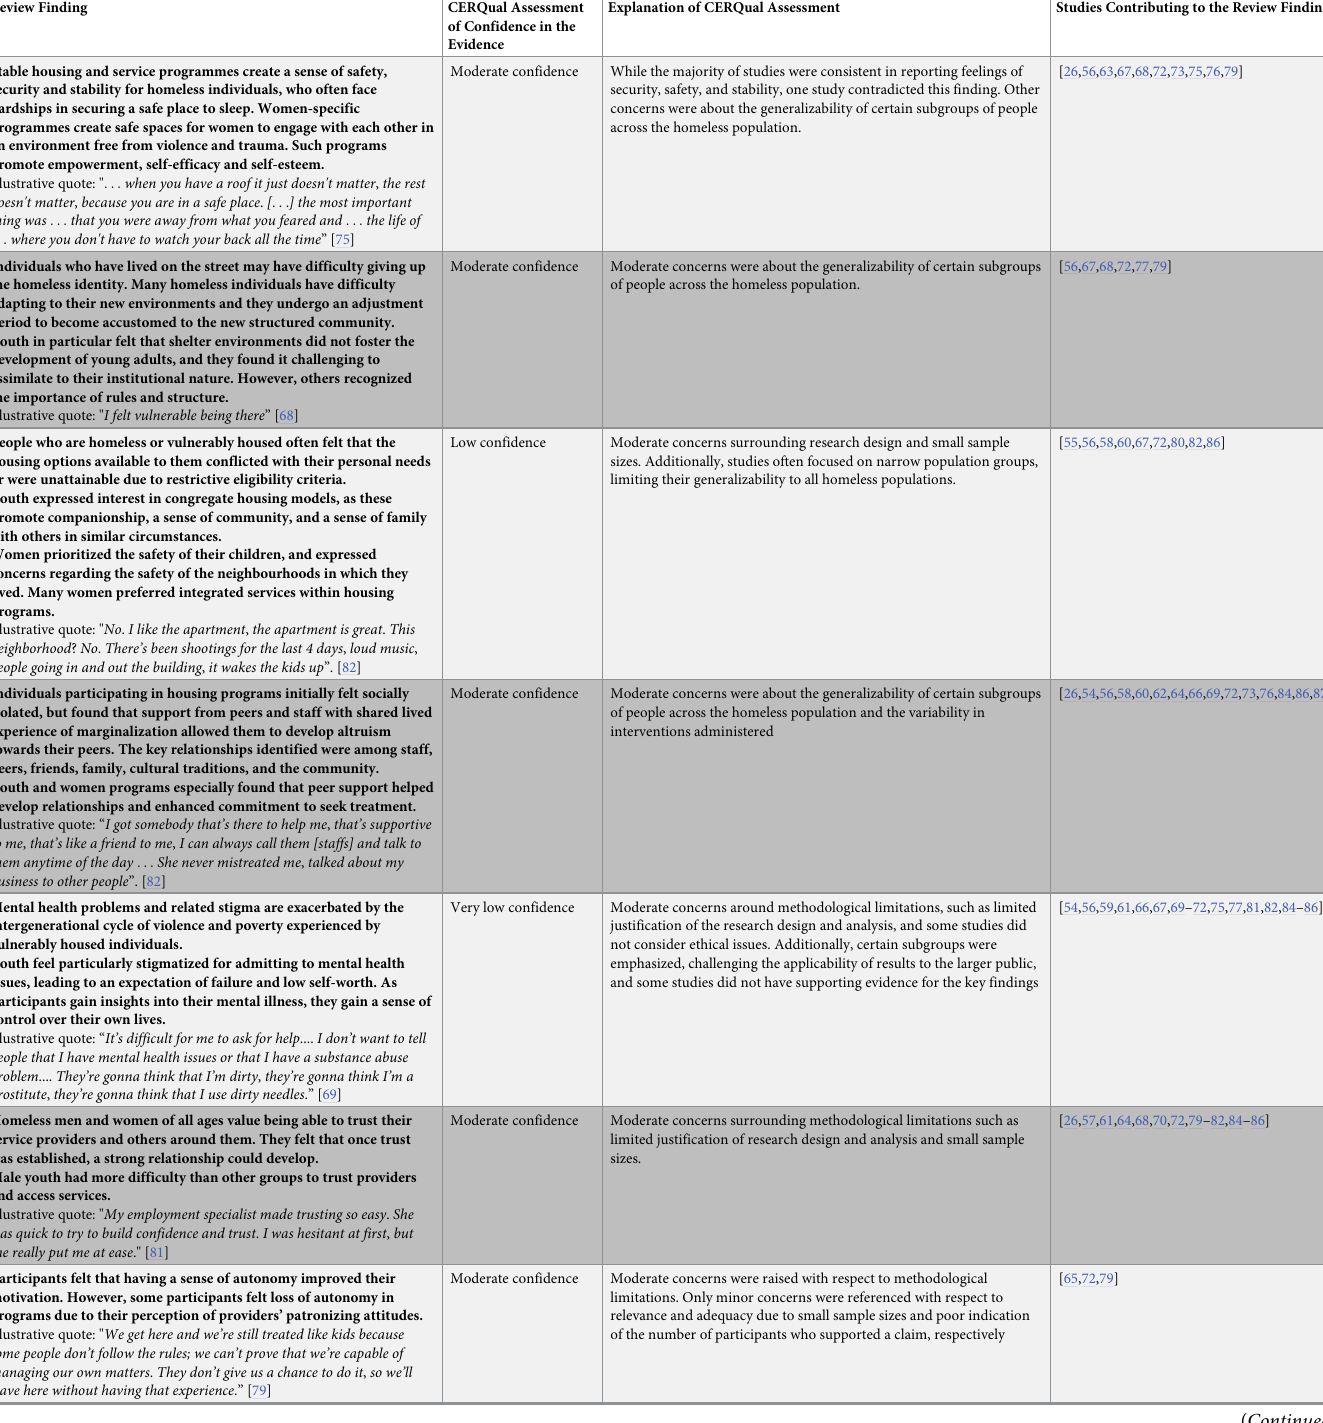
Table 5. CERQual summary of